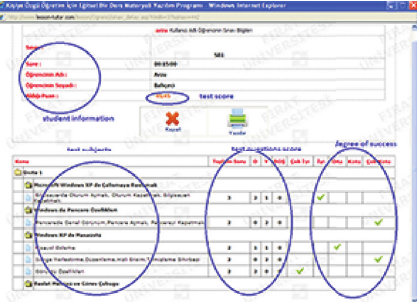
Figure 4: Student assessment